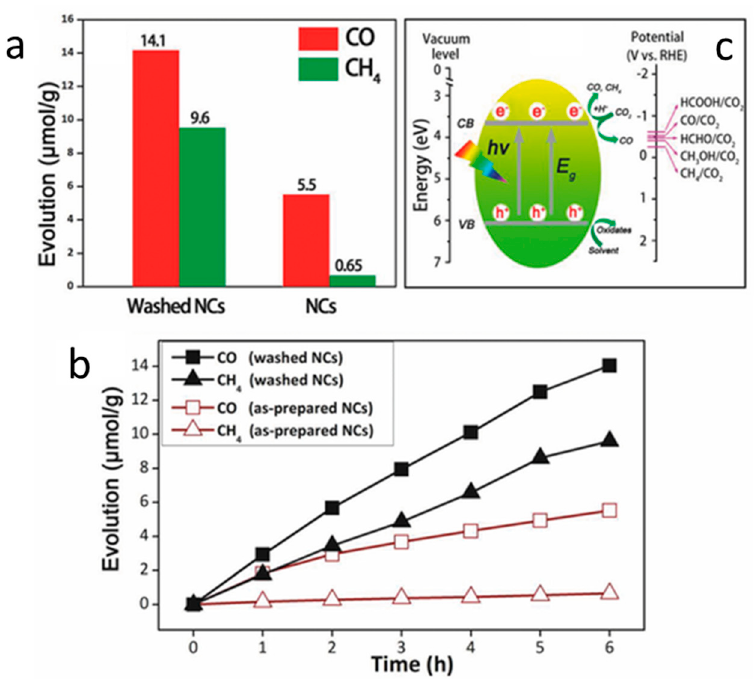
Figure 9. ( a ) CO and CH 4 formation, ( b ) times course product formation in different samples of Cs 2 AgBiBr 6 , and ( c ) Schematic illustration of CO 2 reduction on the surface of Cs 2 AgBiBr 6 . Reproduced from [104], with permission from John Wiley and Sons, 2018.